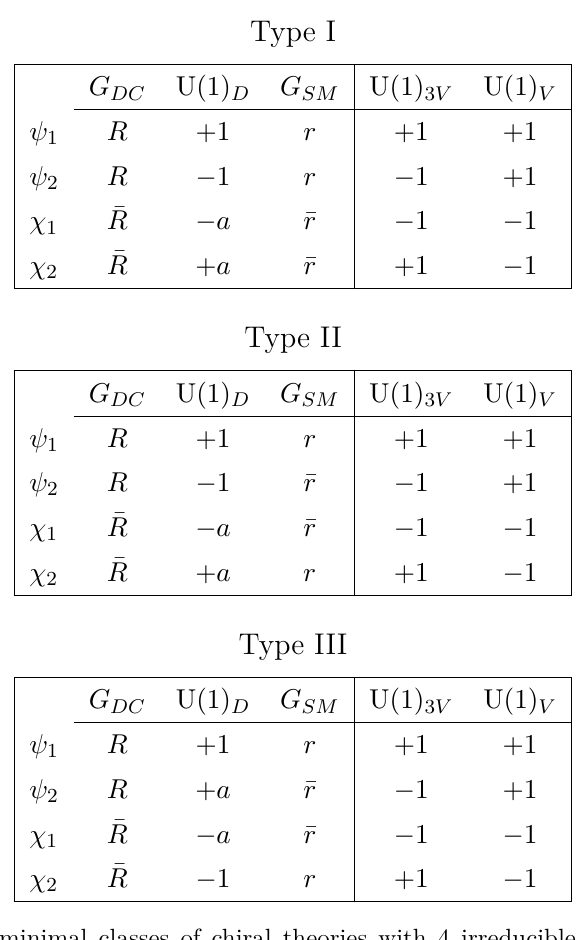
Table 1 . The three minimal classes of chiral theories with 4 irreducible representations of the gauge group G DC × U(1) D × G SM . All fields are left-handed Weyl fermions. Charges under the accidental global U(1) 3 V × U(1) V are indicated in the last column, separated by a vertical line. The parameter a is an arbitrary rational number in the interval [ − 1 , 1) for Type II and III theories, and in the interval [0 , 1) for Type I